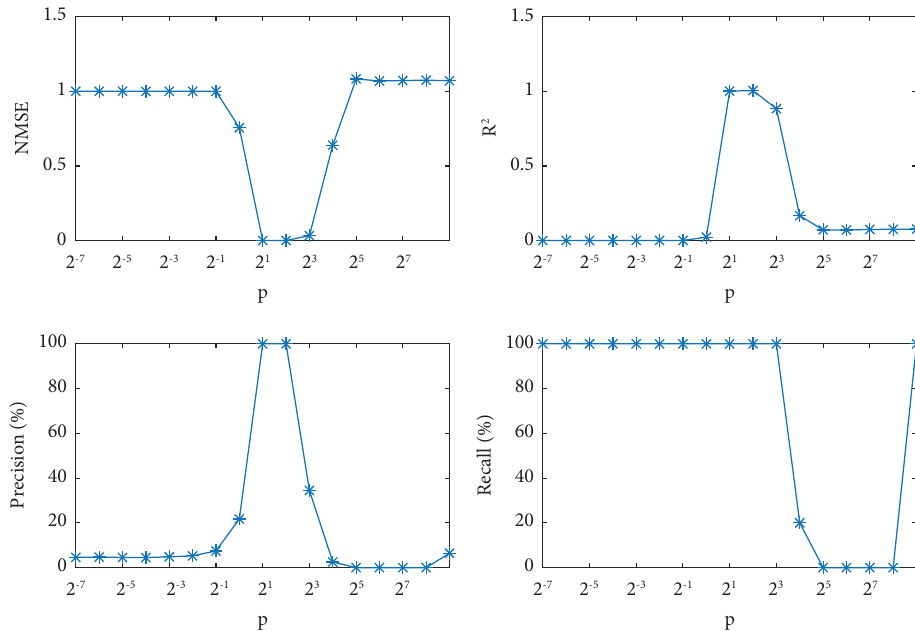
Figure 2: Te infuence of p on NMSE, R 2 , precision, and recall for the Type B dataset. Parameter C is fxed as the optimal